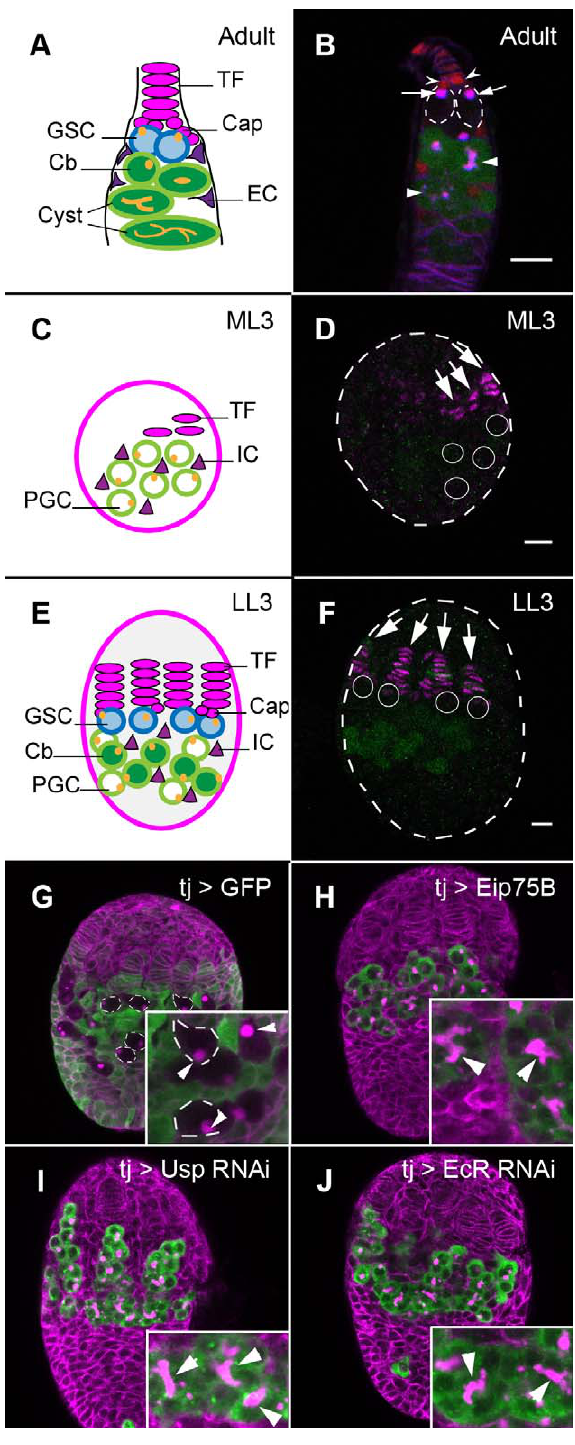
Figure 1. Ecdysone receptors repress precocious PGC differ- entiation. (A) An illustration of an adult germarium. Niche cells (Terminal Filament, TF, and Cap cells) are at the anterior (magenta). Attached to cap cells are the Germ Line Stem Cells (GSCs, blue). GSC progeny (Cystoblast, Cb; and cysts, green) are posterior to GSCs. GSCs and Cbs carry a round fusome (yellow), while germ line cysts carry a branched fusome. Germ cells are also contacted by somatic Escort Cells (ECs, purple). (B) Adult germarium. TF and cap cells (barbed arrowheads) are marked by hedgehog-lacZ (anti b -Galactosidase, red). GSCs (outlined) are attached to cap cells. Fusomes within GSCs